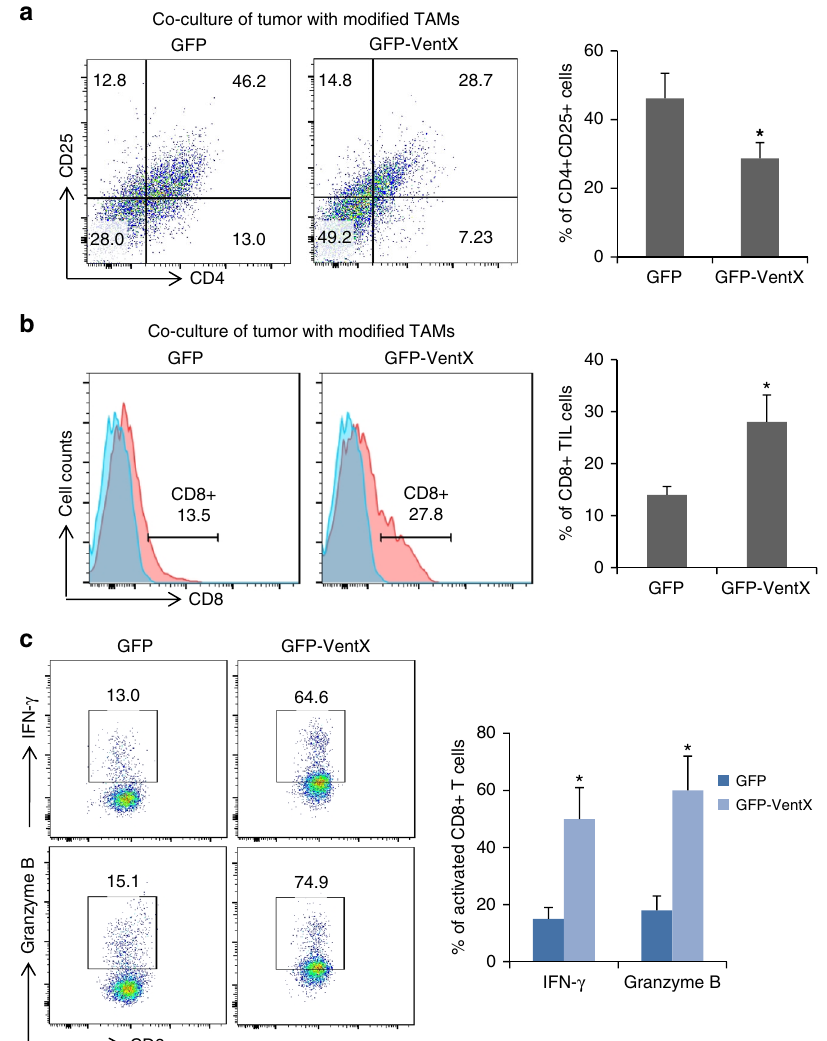
Fig. 5 VentX-regulated TAMs modulate composition and function of TILs in tumor microenvironment. a , b Composition of CD4 + CD25 + Tregs ( a ) and CD8 + TILs ( b ) in tumors after en bloc co-culture of tumor tissues with autologus TAMs transfected with GFP or GFP-VentX for 5 days. c CD8 TILs were isolated from tumor tissues after being incubated with autologus TAMs transfected with GFP or GFP-VentX for 5 days. CD8 + TIL activation was measured by FACS analysis of IFN γ and granzyme B. Data shown are mean ± SD of three independent experiments and paired Student ’ s t -test was performed. * p